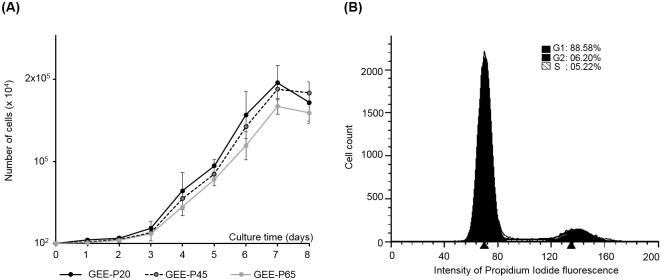
Growth properties of the GEE cell line.(A) Cellular growth curve of the GEE cell line. Cells at passages 20, 45 and 65 were grown at 37°C in a 6-well plate containing 2 ml of the M199 medium supplemented with 10% fetal bovine serum until they reach confluency and then were collected at indicated time points for counting. Errors bars represent standard deviations from three independent experiments. (B) Flow cytometry was used to analyze the cell cycle of the GEE cell line. Cellular DNA was stained with the Propidium Iodide fluorescent dye and fluorescence intensity of cells was measured in the G1, S and G2 phases of the cell cycle.